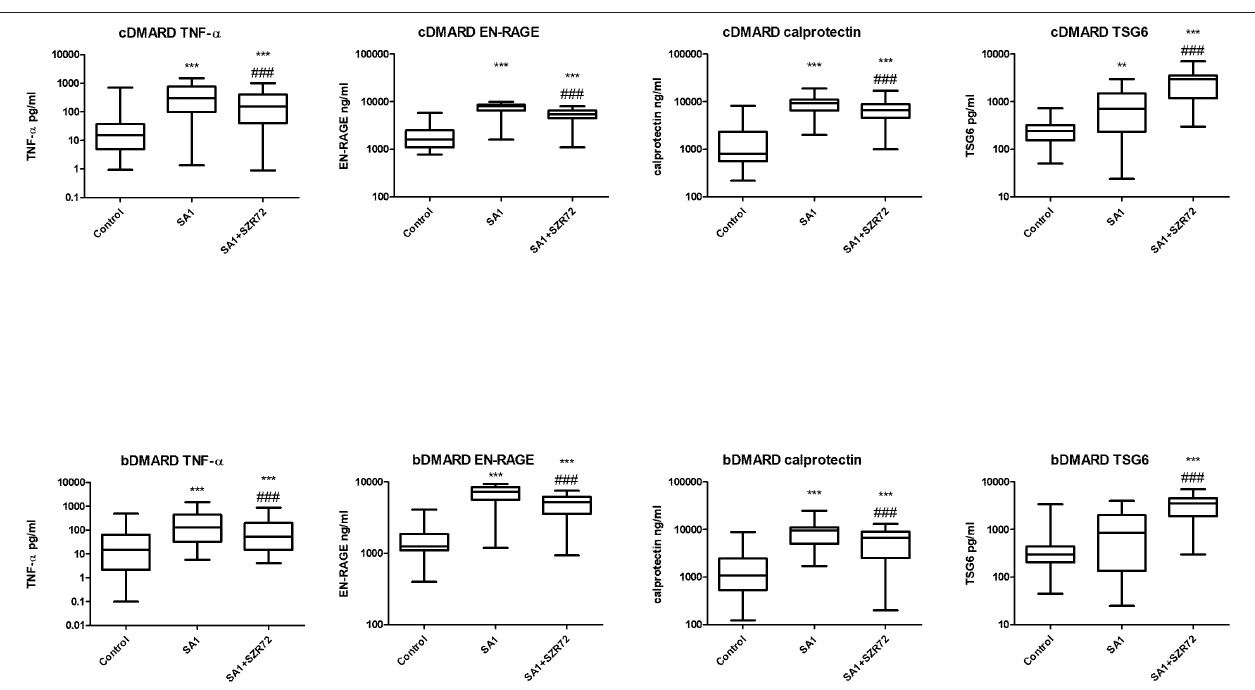
FIGURE 12 | Levels of tumor necrosis factor- α (TNF- α ), EN-RAGE, calprotectin, and TSG-6 at baseline and following treatments with SA1 and SA1 + SZR72 in patients with RA on conventional disease modifying anti-rheumatic drugs (cDMARD, n = 41) or on biologic disease modifying anti-rheumatic drugs (bDMARD, n = 41). Comparisons were made with the Friedman’s test, where ** p < 0.01 vs. control, *** p < 0.001 vs. control, and ### p < 0.001 vs. SA1. Horizontal line—median, box—interquartile range, whiskers—range.